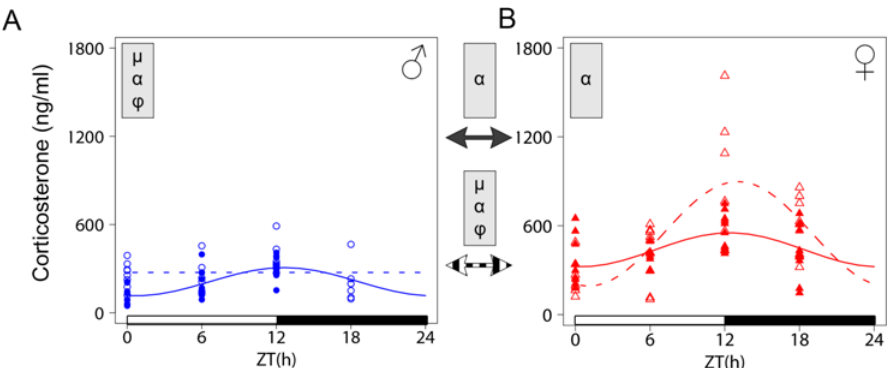
Fig 1. The sexually dimorphic circadian pattern of plasma CORT is differentially altered in male and female Lxr α -/- mice. (A) Rhythm of plasma CORT was determined in wild type (plain line) and Lxr α -/- (dashed line) male mice entrained to a LD12:12 cycle. (B) Same as in (A) except that mice were females. Cosinor based non-linear regression was used for curve fitting. Plotted data were from 10 mice for each experimental group. The ZT0 time point is double plotted for visualization purpose. White and black bars represent the light and dark phases, respectively. Statistically significant differences in cosine fitting